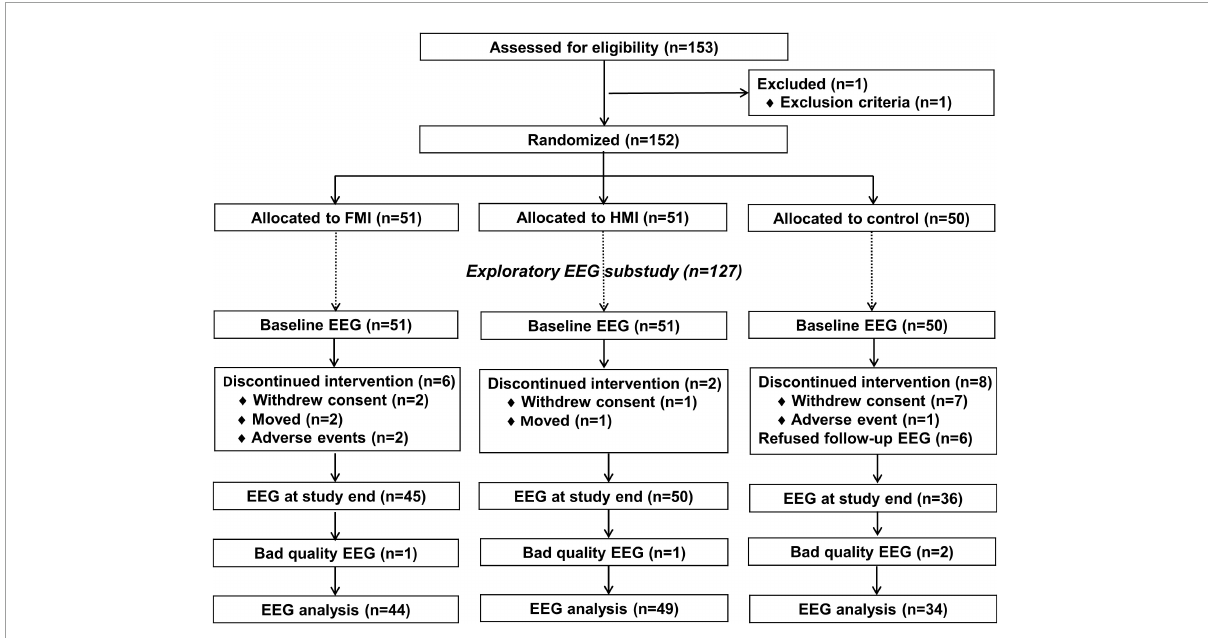
FIGURE1 Diagram depicting the exploratory EEG substudy in the SUPERBRAIN trial. FMI, facility-based multidomain intervention; HMI, home-based multidomain intervention; EEG,